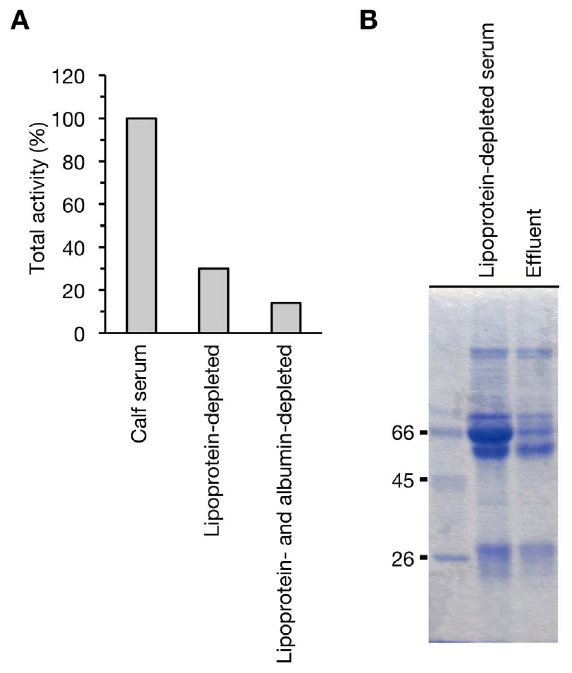
Figure 6. Lipoprotein and albumin-depleted serum decreases colony-spreading stimulatory activity. (A) Stimulatory activities of calf serum, lipoprotein-depleted serum, lipoprotein- and albumin- depleted serum were examined. Fractionation was performed from a 50-ml volume of calf serum containing 3850 units of stimulatory activity. Each fraction was applied to soft agar by 2-fold serial dilution and their colony-spreading stimulatory activities on the MRSA NI-15 strain were measured. Relative total activities of each fraction compared with that of calf serum are presented in graph. (B) SDS-PAGE analysis of the lipoprotein-depleted serum and Affi-Gel blue gel column effluent. 10 m g protein of the lipoprotein-depleted serum and the Affi-Gel blue gel column effluent was electrophoresed in 12.5% SDS-polyacrylamide gel.